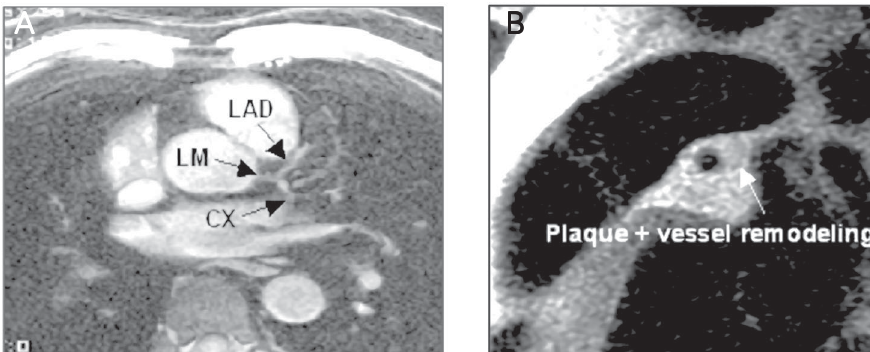
).Figure 3. LA/TVA ratio for the right coronary artery (RCA; left) and left anterior descending ar- tery (LAD; right) of patients and controls. Patients: filled col- umns; control subjects: open columns. The reduced ratio for patients with coronary artery dis- ease was due to vessel enlarge- ment. LA = luminal area; TVA = total vessel area. *P < 0.05 compared to control subjects (Mann-Whitney Figure 4. Magnetic resonance image of a 43-year-old male pa- tient. A , View of the left main (LM), left anterior descending (LAD) and circumflex (CX) ar- teries. B , A cross-sectional view of the LAD with a clearly posi- tive remodeling (arrow) be- tween 1 and 5 h (total vessel area = 37 mm 2